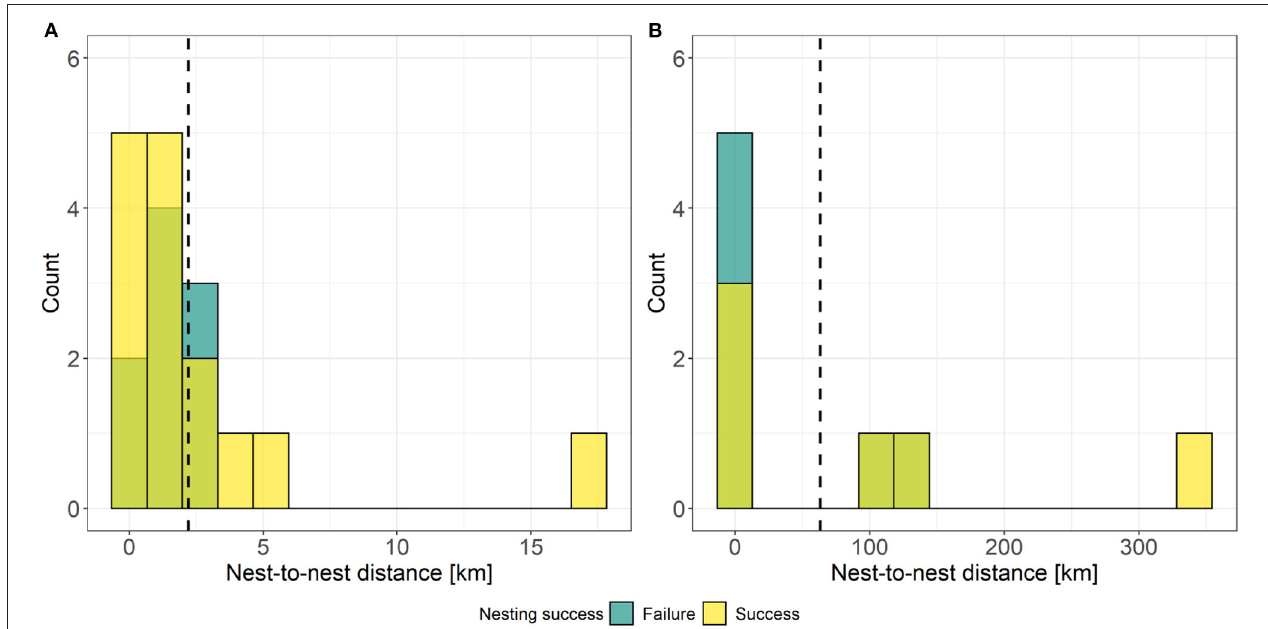
FIGURE 7 | Histogram of the distance between the nests of the current and the following year (nest-to-nest distance) for (A) stable and (B) variable resources. Dashed line represents the mean